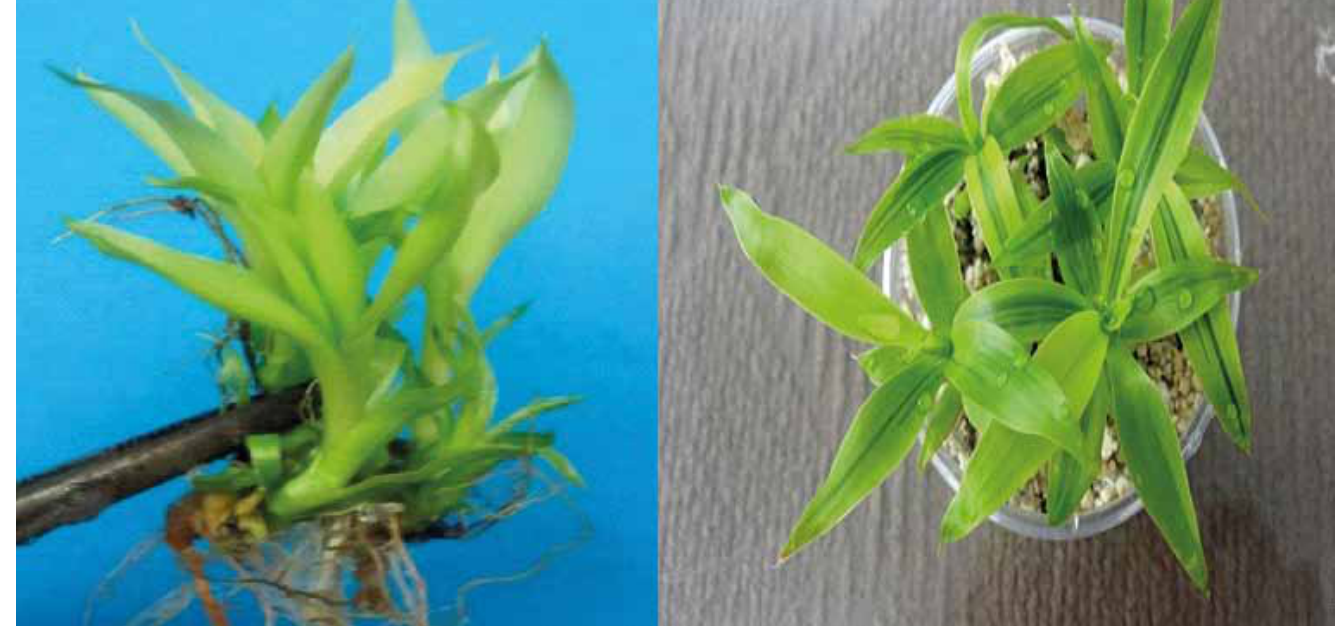
Fig. 4 - Acclimated ‘Variegated’